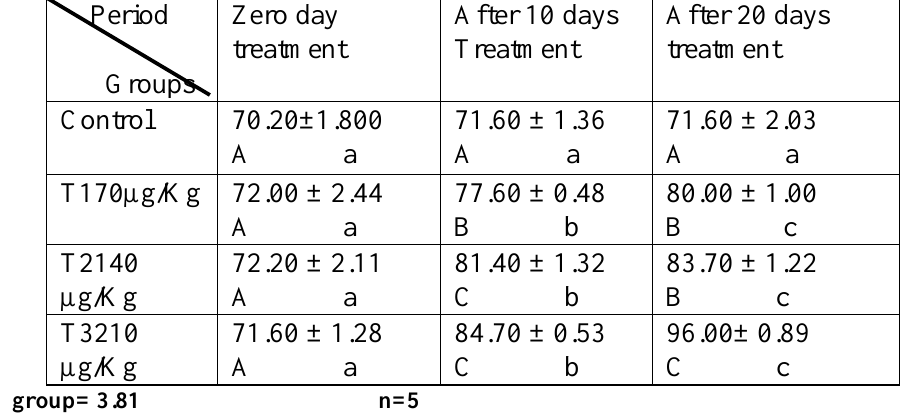
Table (1): AST (I.U/ml) in rats serum of different experimental groups dosed orally with ochratoxin A at different doses and periods.